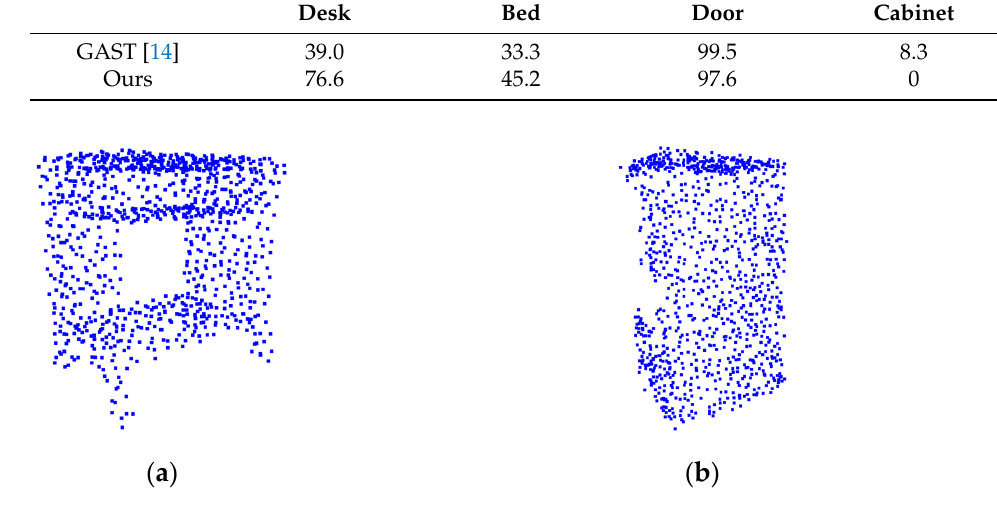
Figure 5. Examples of object categories with similar characteristics in ScanObjectNN-11. ( a ) Cabinet. ( b ) Door. ( c ) Bed. ( d ) Desk.